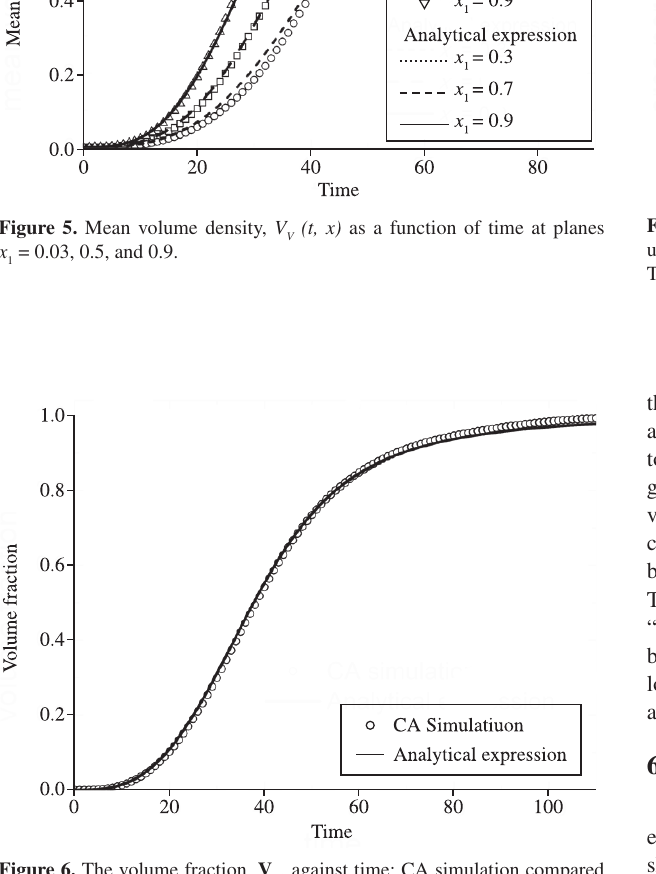
, against time: CA simulation compared V